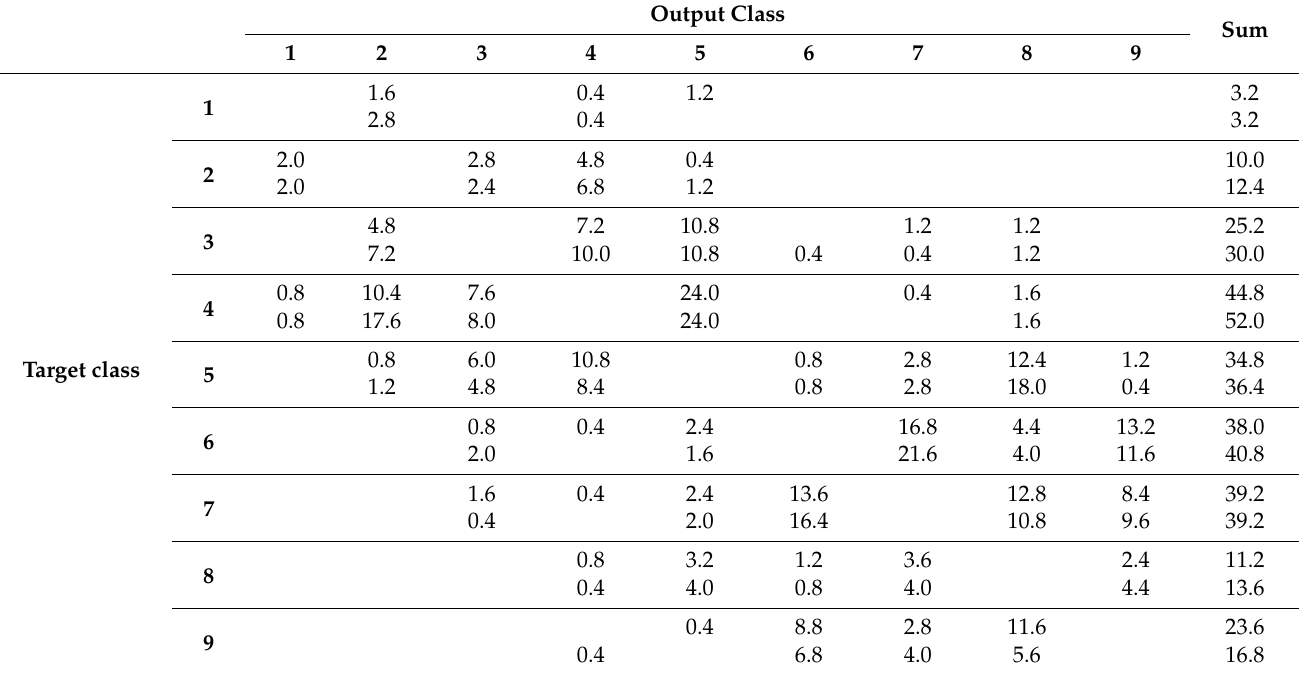
Table 7. Average misclassification rates (%) on validation data using the XZ O -based features with (upper row) and without (lower row) using the detection length